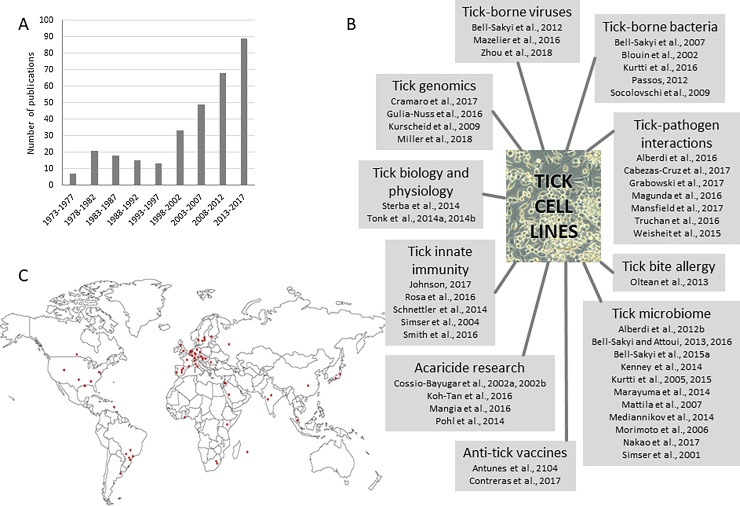
Impact of tick cell lines and the Tick Cell Biobank in global tick and tick-borne disease research. A. Number of publications reporting generation and/or use of tick cell lines over the past 45 years. Data from https://www.liverpool.ac.uk/infection-and-global-health/research/tick-cell-biobank/bibliography/.B. Selected reviews and original research papers illustrating the broad spectrum of research topics in which tick cell lines play a role: Antunes et al. (2014), Bell-Sakyi and Attoui (2013), Bell-Sakyi and Attoui (2016), Blouin et al. (2002), Cabezas-Cruz et al. (2017), Contreras et al. (2017), Cossio-Bayugar et al. (2002a), Cossio-Bayugar et al. (2002b), de Abreu et al. (2013), Grabowski et al. (2017), Gulia-Nuss et al. (2016), Hoffmann et al. (1970), Johnson (2017), Kenney et al. (2014), Kurscheid et al. (2009), Kurtti et al. (2015), Kurtti et al. (2008), Magunda et al. (2016), Mansfield et al. (2017), Marayuma et al. (2014), Mattila et al. (2006), Mediannikov et al. (2014), Morimoto et al. (2006), Nakao et al. (2017), Oltean et al. (2013), Passos (2012), Rosa et al. (2016), Schnettler et al. (2014), Simser et al. (2004), Simser et al. (2001), Smith et al. (2016), Socolovschi et al. (2009), Sterba et al. (2014), Tonk et al. (2014a), Tonk et al. (2014b) and Truchan et al. (2016). C. Locations of institutes working with tick cell lines supplied by the Tick Cell Biobank (due to the small scale, it is not possible to indicate all the institutes in UK and Europe individually).